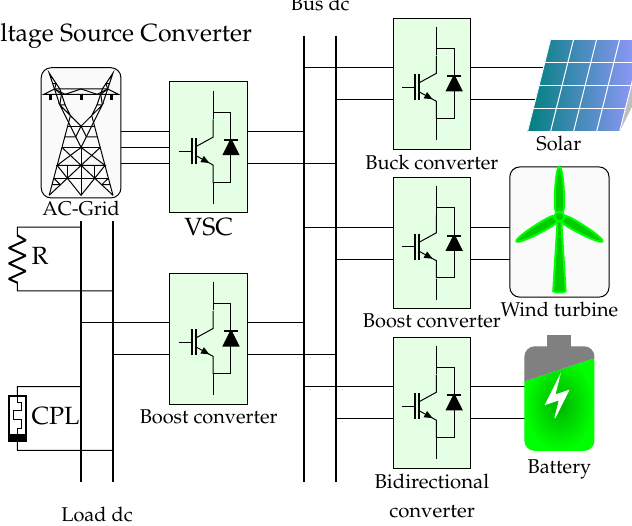
Figure 1. Some classical converters employed to interface distributed energy resources and loads in DC